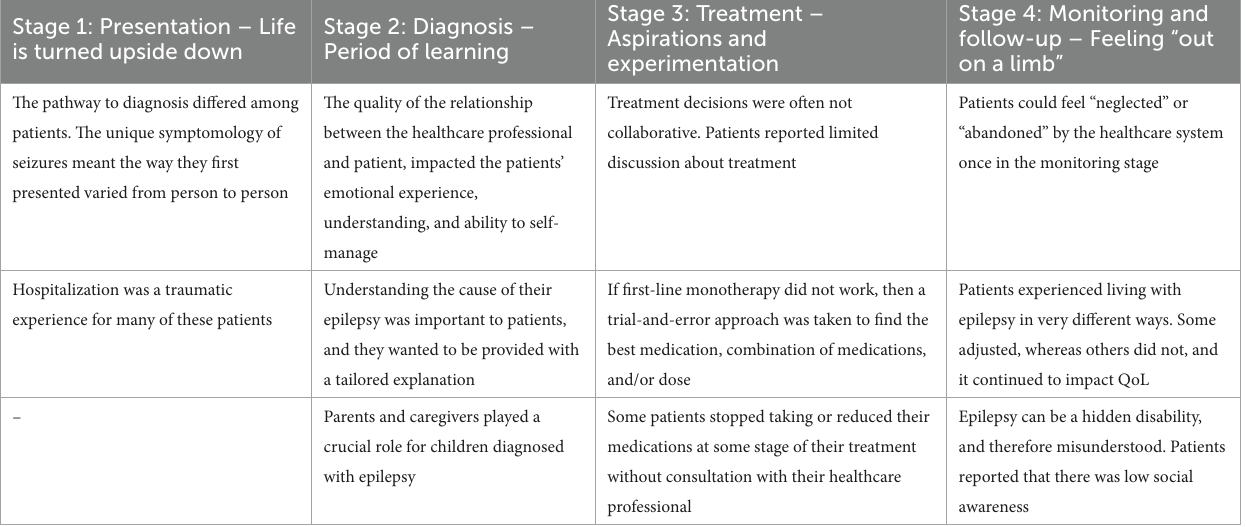
Stage 2: Diagnosis – Period of